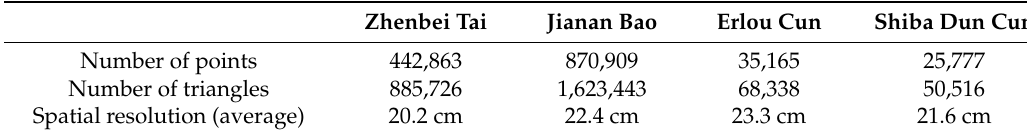
( c ) Figure 13. 3D model of Great Wall displayed on a web browser, ( a ) interface for the 3D visualization on the web; ( b ) distance measurement between two points of interest on the Zhenbei Tai (for a better view, the model is shown in grid mode); ( c ) comparison between two models of Zhenbei Tai built at different time periods (white for July 2015, red for October 2014). 4. Discussions In the field of 3D modeling of cultural heritage sites, most previous studies [3,5,7,13] have utilized TLS instead of airborne laser scanning (ALS). Although ALS technology has shown its